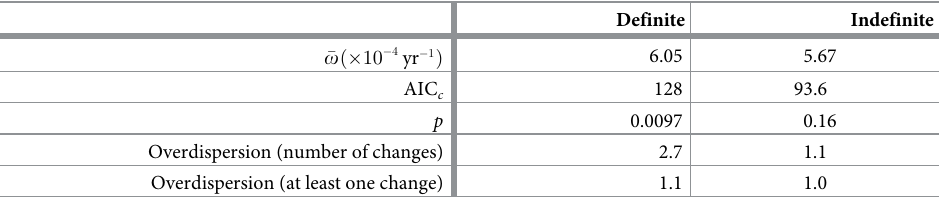
Table 3. Fit of a Poisson process to article grammaticalisation